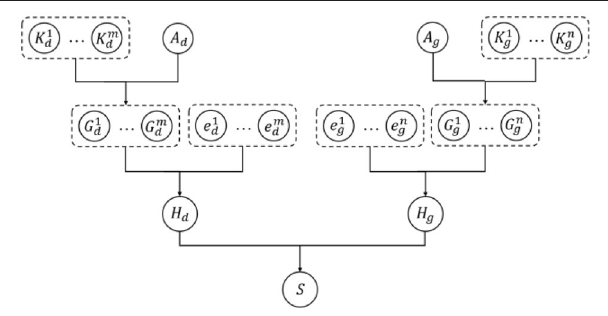
FIGURE 6 | Diagram of kernelized Bayesian matrix factorization algorithm.